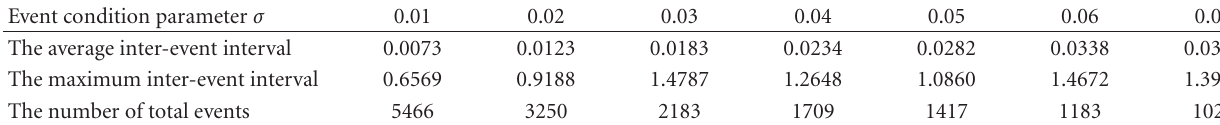
Table 1: The comparison in terms of inter-event intervals for several values of σ .